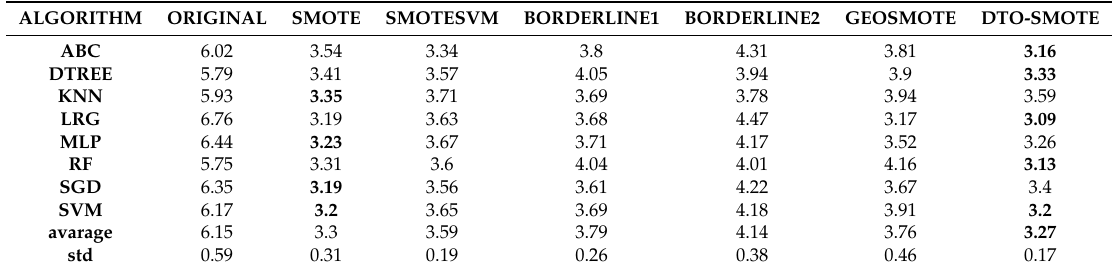
Table 7. Geometric Mean (GEO) rank (solid angle and α = 7.0); see Table 5.